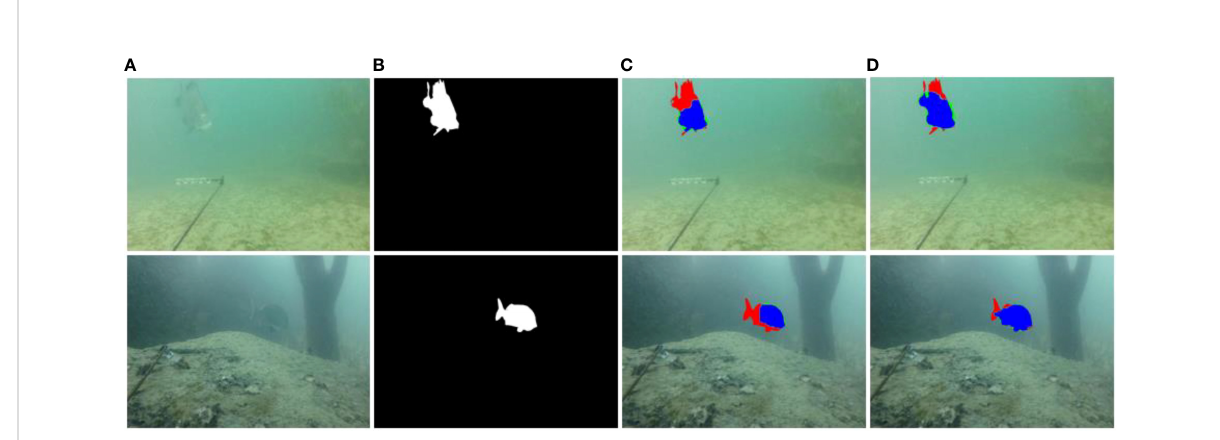
FIGURE 9 Poor segmentation sample qualitative results by EFS-Net and MFAS-Net on the DeepFish dataset (A) original test image, (B) ground truth image, (C) segmented images achieved by applying EFS-Net, and (D) segmented images achieved by MFAS-Net (the fp and tp pixels are referred by green and blue colors, respectively. Pixel representation for fn is done with red color).